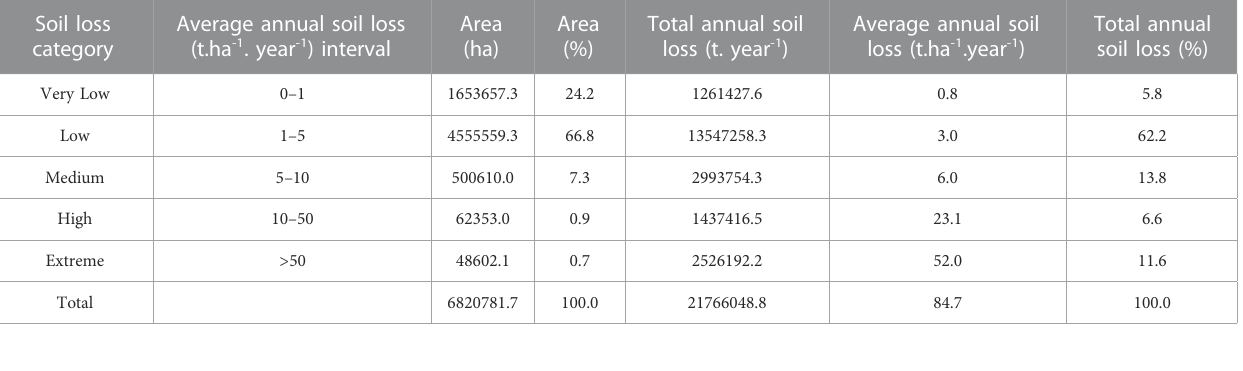
TABLE 5 Average annual soil loss under different severity classes in Banas basin.